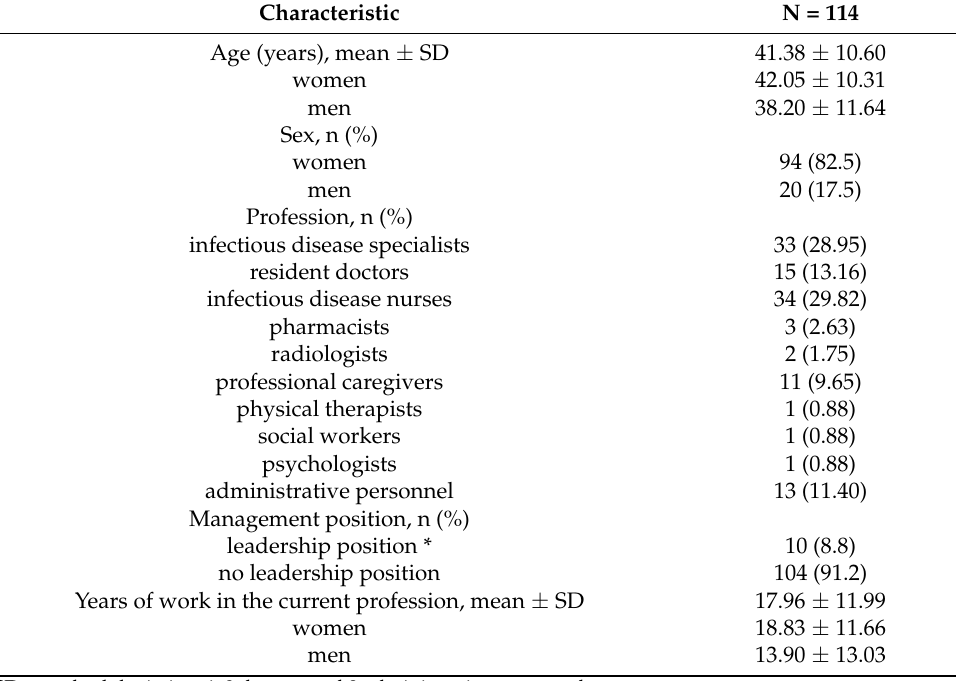
Table 2. Demographics and professional characteristics of